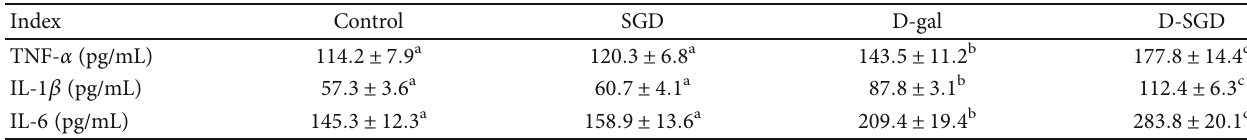
Table 2: E ff ects of serine de fi ciency on levels of serum in fl ammatory cytokines in D-galactose-treated mice.